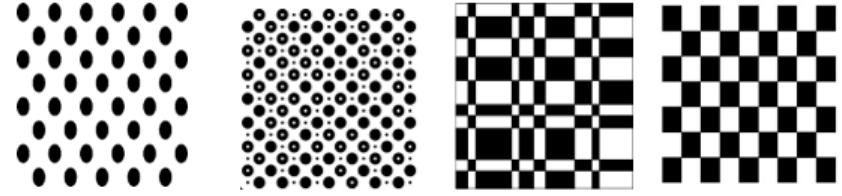
Figure 4. Example of a well-defined calibration pattern.